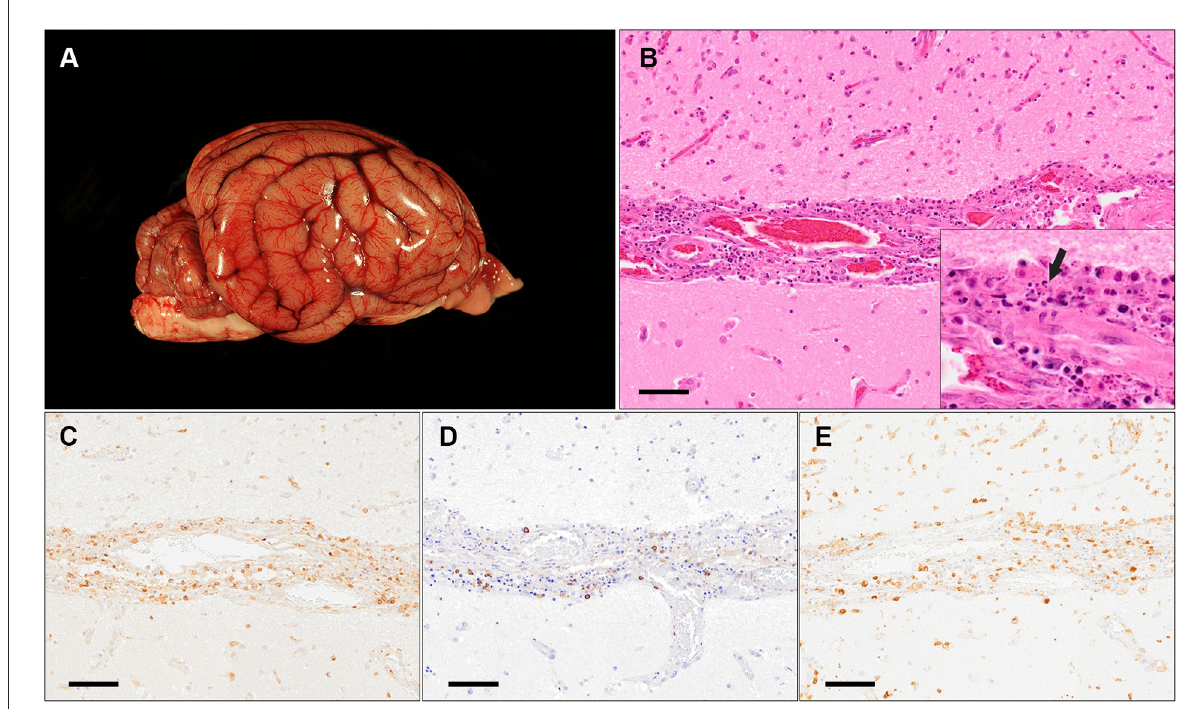
FIGURE2 Macroscopic and histopathological findings of a 1.25 year old Chihuahua (case 1). (A) Macroscopic image of the brain with mild narrowing of sulci and flattening of gyri interpreted as edema. (B) Histopathology of the cerebral cortex at the level of the temporal lobe with moderate, leukocytoclastic vasculitis of the leptomeningeal blood vessels with fragments of degenerated inflammatory cells (arrow in insert) visible within the destructed vascular wall (HE stain; scale bar: 50 µ m). (C–E) Immunohistochemistry for CD3 (C) , CD20 (D) and CD204 (E) shows that the majority of infiltrating cells are comprised of T-lymphocytes [ (C) ; CD3-positive] and macrophages [ (E) ; CD204-positive] (Scale bars: 50 µ m).